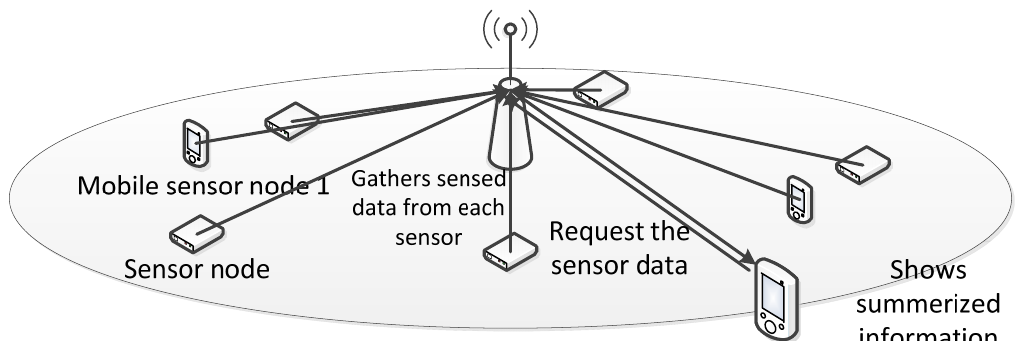
Figure 5. Massive uplink scenario for an Internet of Things (IoT) device.